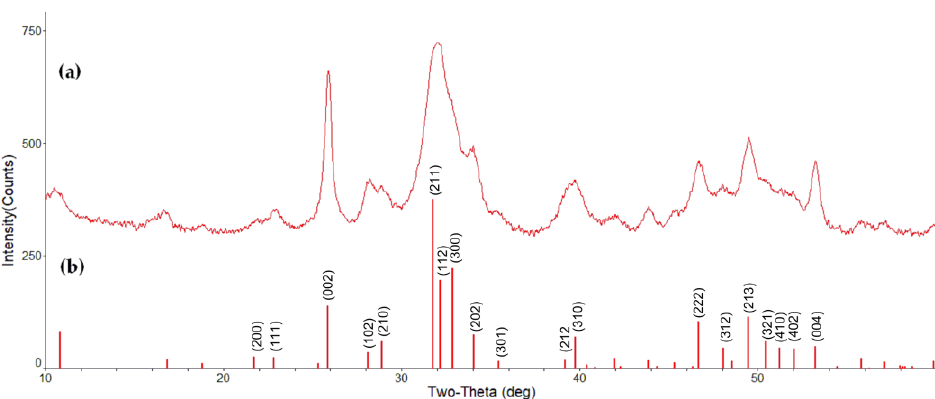
Figure 2. XRD pattern of HAp obtained ( a ) and standard HAp (JCPDS 09-0432) as reference ( b ). From transmission electron microscopy (TEM) data (Figure 3a,b), HAp particles were